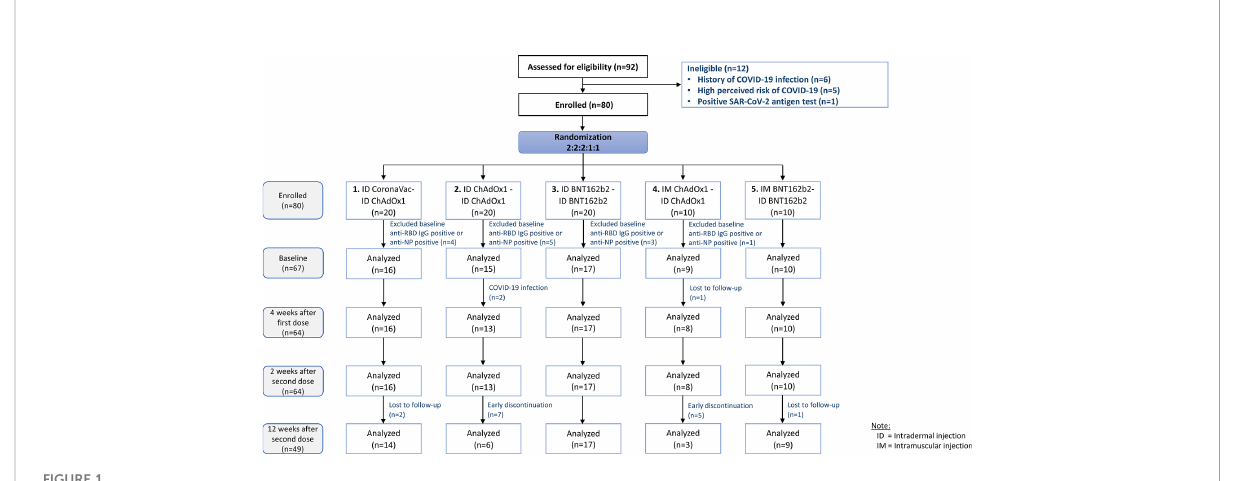
FIGURE 1 CONSORT subject fl ow